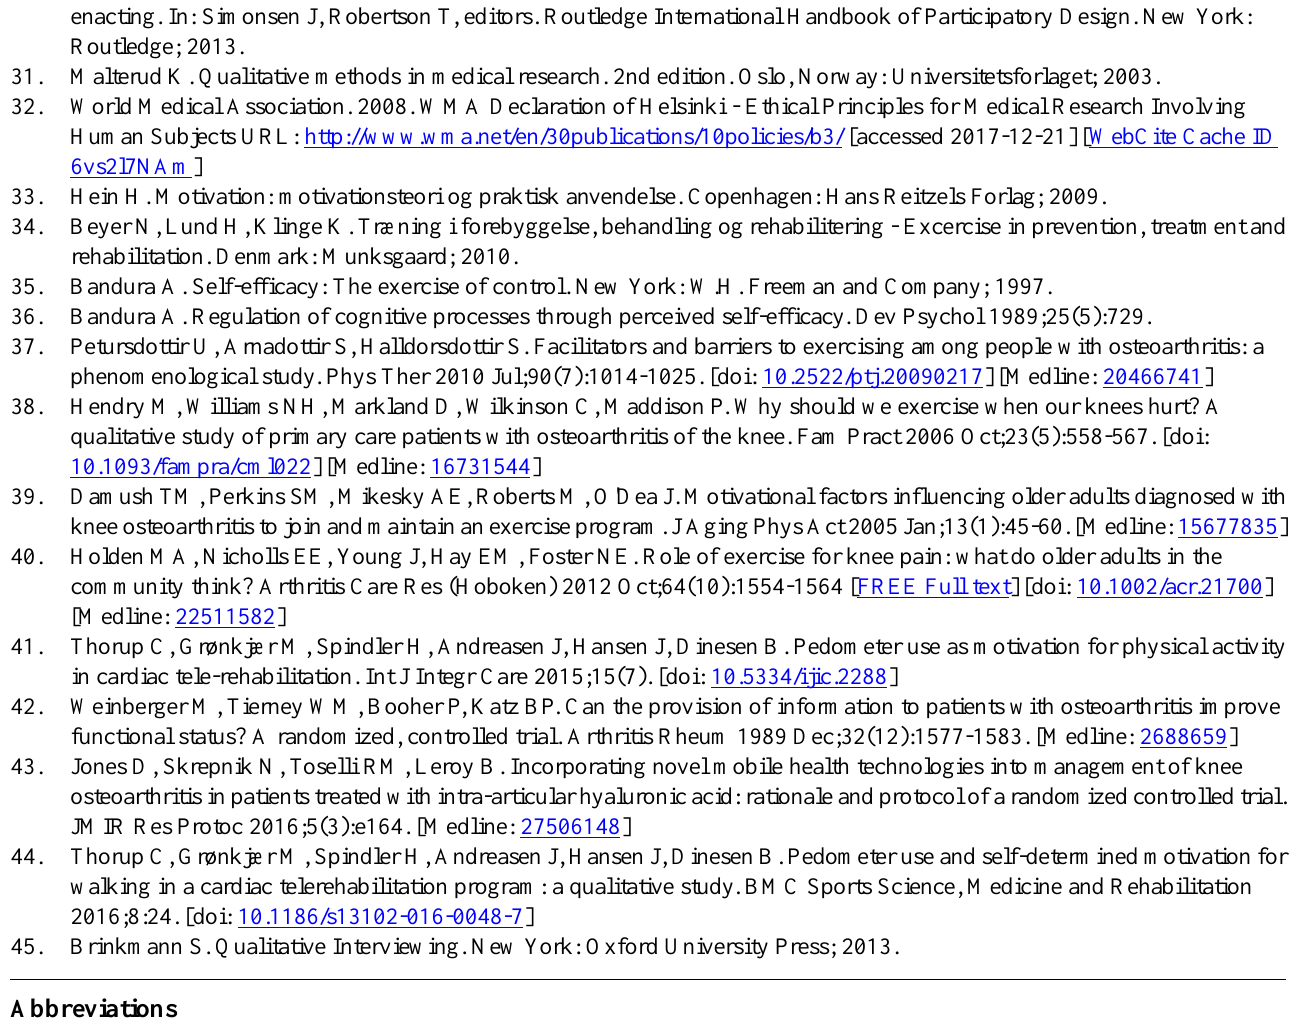
Abbreviations GLA:D: Good Life with osteoArthritis in Denmark OA: osteoarthritis PD: participatory design Ther-ex: Therapeutical